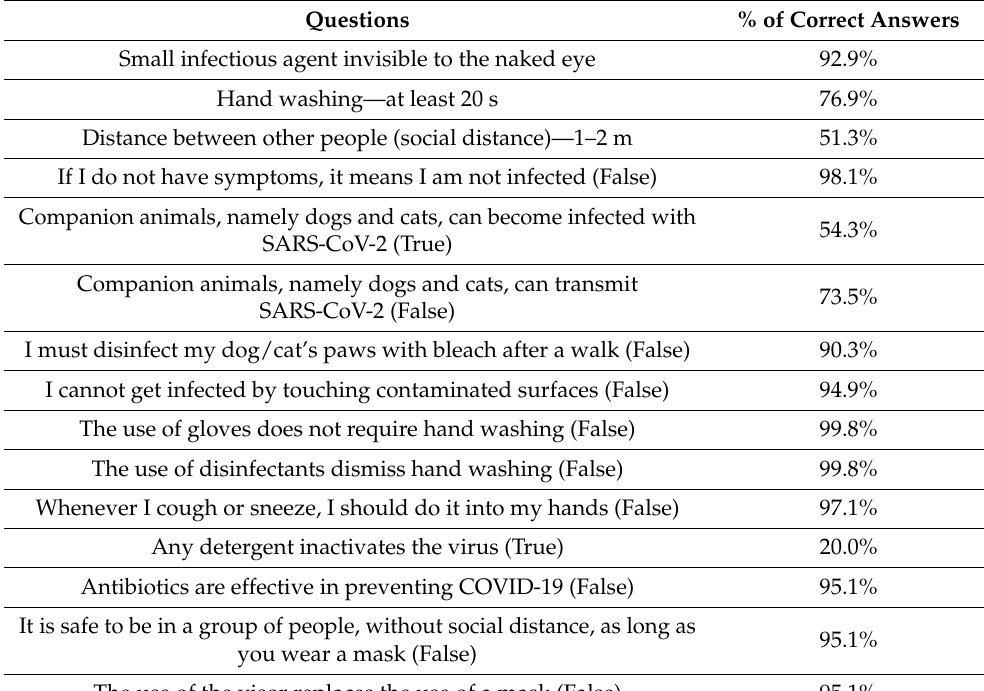
Table 2. General knowledge about COVID-19 (n =